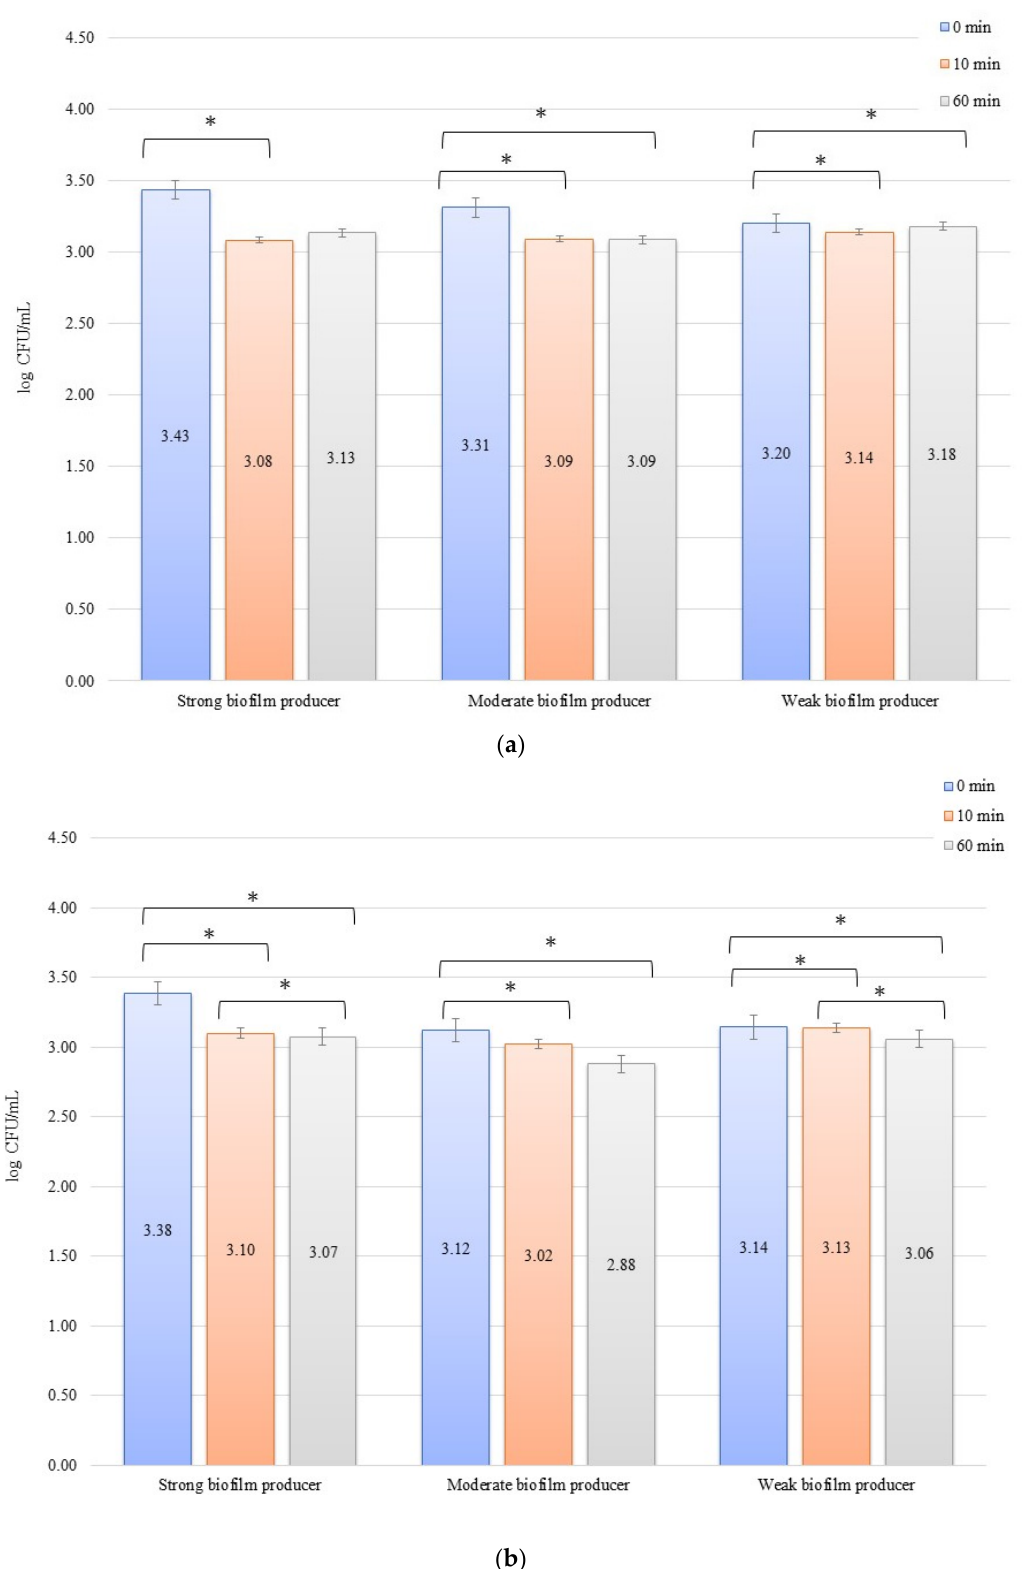
Figure 4. Biofilm inhibition assay for Staphylococcus aureus . Strains forming biofilms on Ti-6Al-4V ( a ) and zirconium dioxide ( b ) discs classified as strong, moderate, weak, and non-producers are treated with low direct electric currents of 1 mA. Error bars represent the pooled standard deviations of the mean. The level of significance is presented at * p < 0.05. The mean and standard deviation are shown.